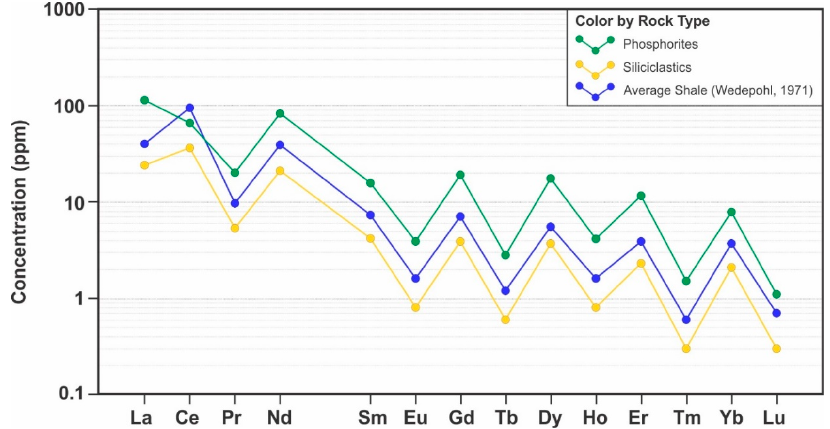
Figure 18. Profiles of the average concentration of REE for the phosphorite and siliciclastic facies, and the average shale [43], showing overall REE enrichment and relative Ce depletion in the phosphorites. In addition to the correlation with REE and Sr, apatite also has strong positive correlations with U and Ba; however, the interpretation is more complex. The substitution of U 4+ in Ca 2+ sites [63,64] accounts for the U anomaly in the phosphorite facies, although a distinct relationship with TOC is observed for concentrations of much lower magnitude, due to the chelation of U with organic matter. The solid solution between Ba 2+ and Ca 2+ in the structure of fluorapatite [65] may account for its high